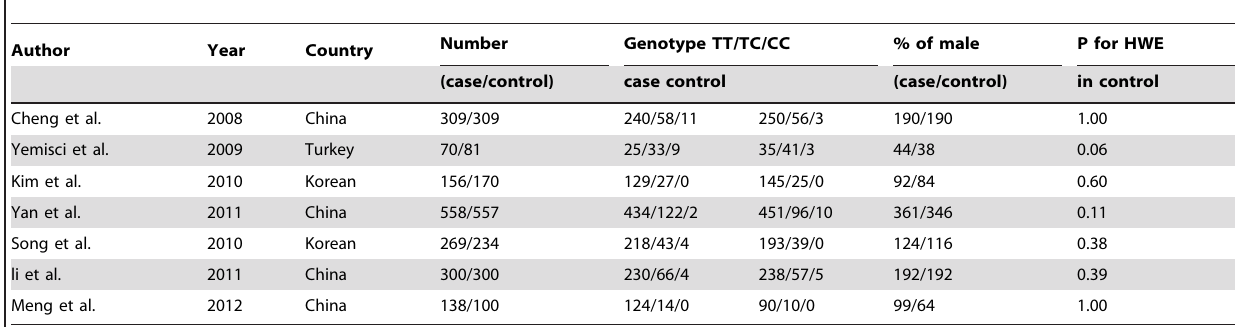
Table 2. Characteristics of eNOS gene T-786C polymorphism genotype distributions in studies included in this meta-analysis.